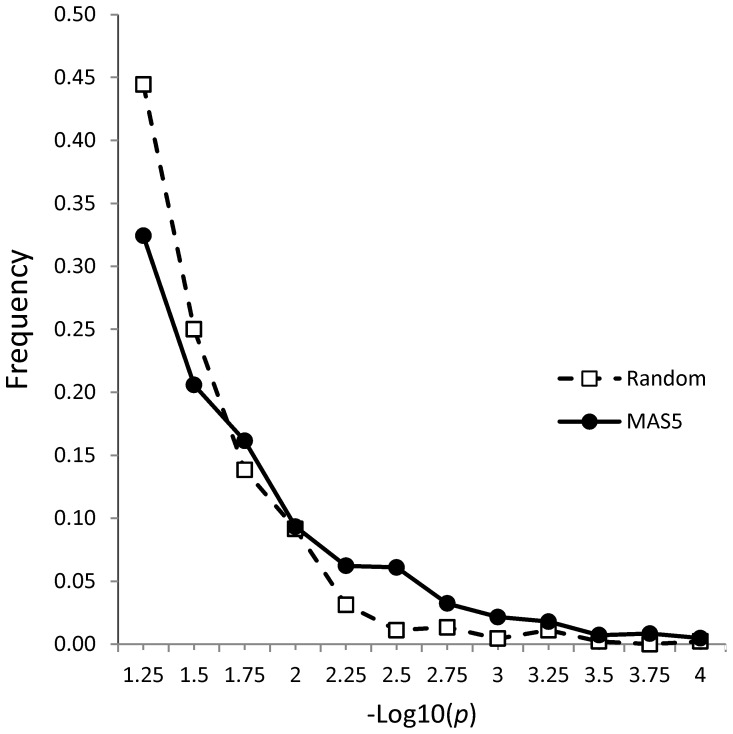
Functional annotation analysis demonstrates that differentially expressed probe sets represent true biological difference between control and depressed suicide subject groups.Comparison of functional annotation analysis of differentially expressed probe sets generated at different p and FC cut-offs and randomly generated probe sets lists of the same size. Note the shift of the experimental curve to the right.